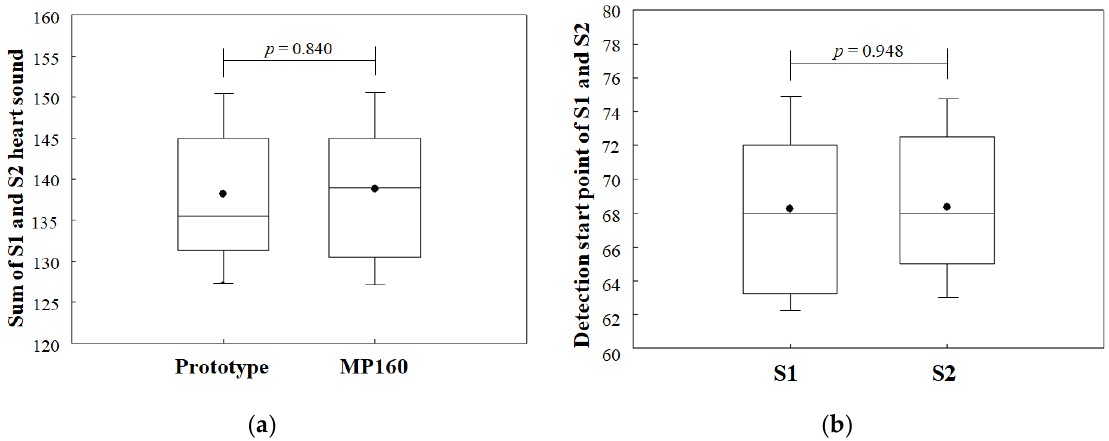
Figure 14. Results of the automatic identification of S1 and S2 heart sounds by the developed algorithm: ( a ) results for comparison of start-points of heart sounds detected by the prototype device using the developed algorithm and the MP160; ( b ) boxplot of the similarity analysis with a Wilcoxon paired-samples test for automatic start-points of S1 and S2 heart-sound identification using the developed algorithm.